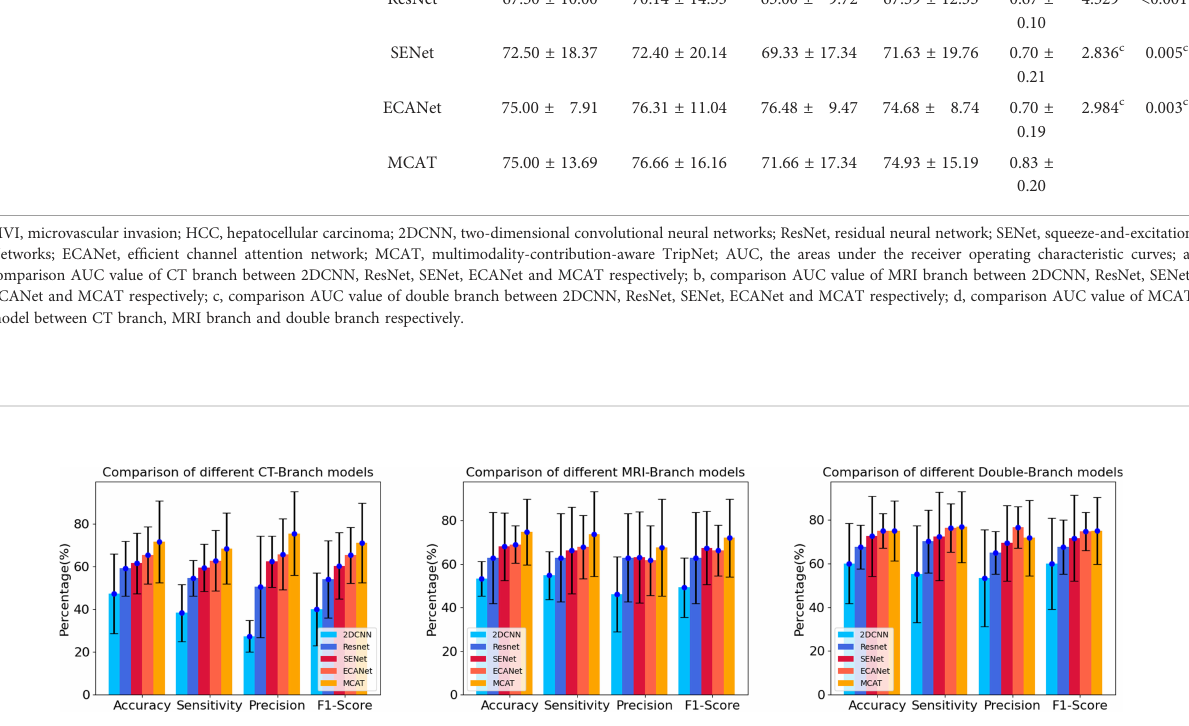
FIGURE 3 Histograms of accuracy, sensitivity, precision and F1 score of different networks in CT branch, MRI branch and double branch models. The heights of the blue, dark blue, red, orange and yellow histograms represent the average values of accuracy, sensitivity, precision and F1 score in the CT branch, MRI branch and double branch, respectively, using different deep neural networks. The short black line at the top of the histograms represents the standard deviation of of the corresponding